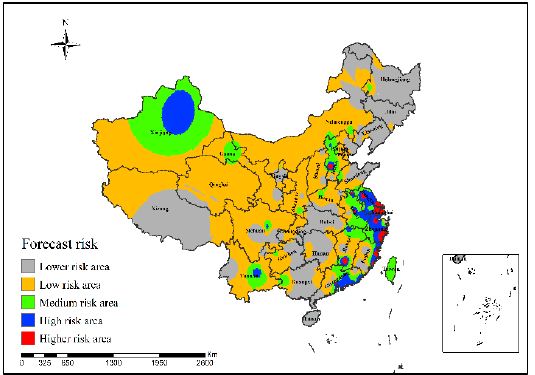
Figure 15. Risk simulation results of H7N9 outbreaks in China in 2015.